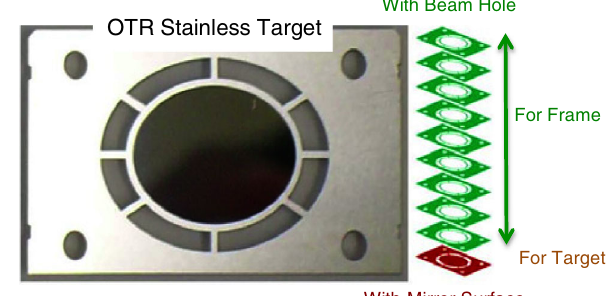
FIG. 8. Stainless-steel OTR screen (a 100 (cid:1) m thickness). Ten foil targets with a 100 (cid:1) m thickness, each of which are joined by the diffusion bonding method. One target has a mirror surface of a 40 nm roughness to take a beam image, and the other to make a firm frame has a beam hole.